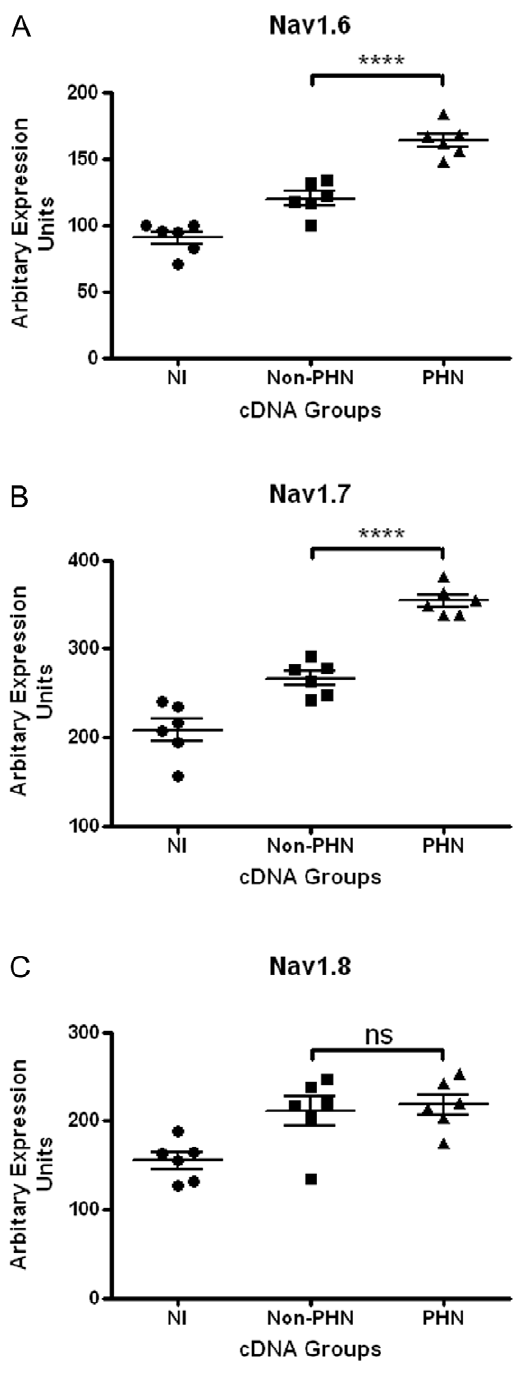
Figure 1. RT.PCR end-point analysis depicting expression of (A) Nav 1.6, (B) Nav 1.7 and (C) Nav 1.8 genes in non-infected ND7/ 23-Nav1.8 cells (NI) and cells infected with SVSs prepared from non-PHN VZV isolates (Non-PHN) and PHN VZV isolates (PHN). Each grouping comprised six cDNAs representing three separate experiments. One-way ANOVA-Bonferroni Multiple Comparison Test analysis shows a modest but statistically significant increase (**** P , 0.0001) in the transcriptional activity of the Nav 1.6 and Nav 1.7 genes between the non-PHN and PHN groupings and contrasted to Nav 1.8 mRNA levels which remained essentially invariant (ns) between the non-PHN and PHN groups.